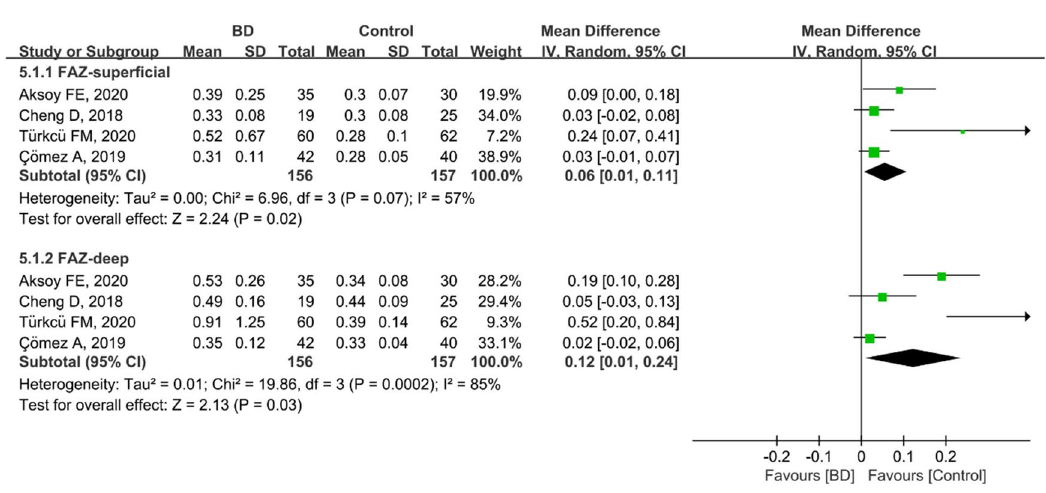
Figure 11. Forest plot for FAZ superficial and deep in eyes with BD and